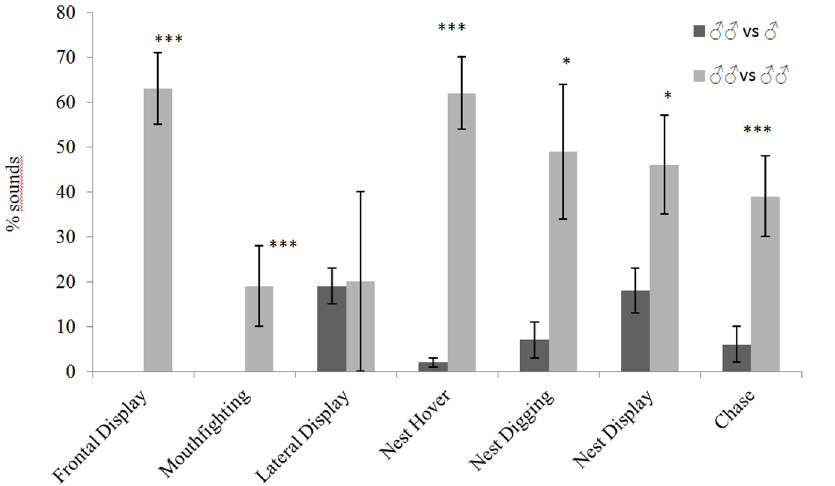
Figure 4. Histogram of the average percentage (mean ± SE) of sound production during the display of different behaviours in Oreochromisniloticus males during different kinds of encounters. * p , 0.05, *** p , 0.001: significant differences between light and dark grey bars (Mann-Whithney test). == =territorial male; = =intruder male. The statistical test cannot cannot be applied to Frontal display and Mouth fighting because these behaviours were not recorded in == vs = .